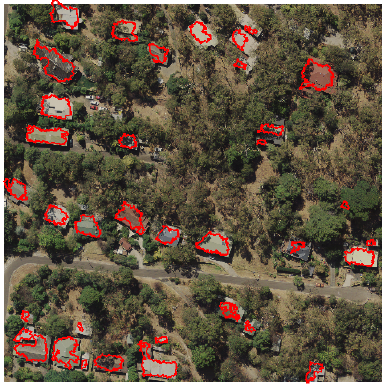
Figure 8: Detected building boundary in the Knox data set. The area omission error, which represents the percentage of the non-detected building parts is lower than 10% for first three data sets. The area commission error, which represents the percentage of incorrectly detected buildings is also lower than 10% for first three data sets. Branching factor, which measures the degree of over segmentation of buildings non-building parts is also within a reasonable range. The miss factor, which represents the degree